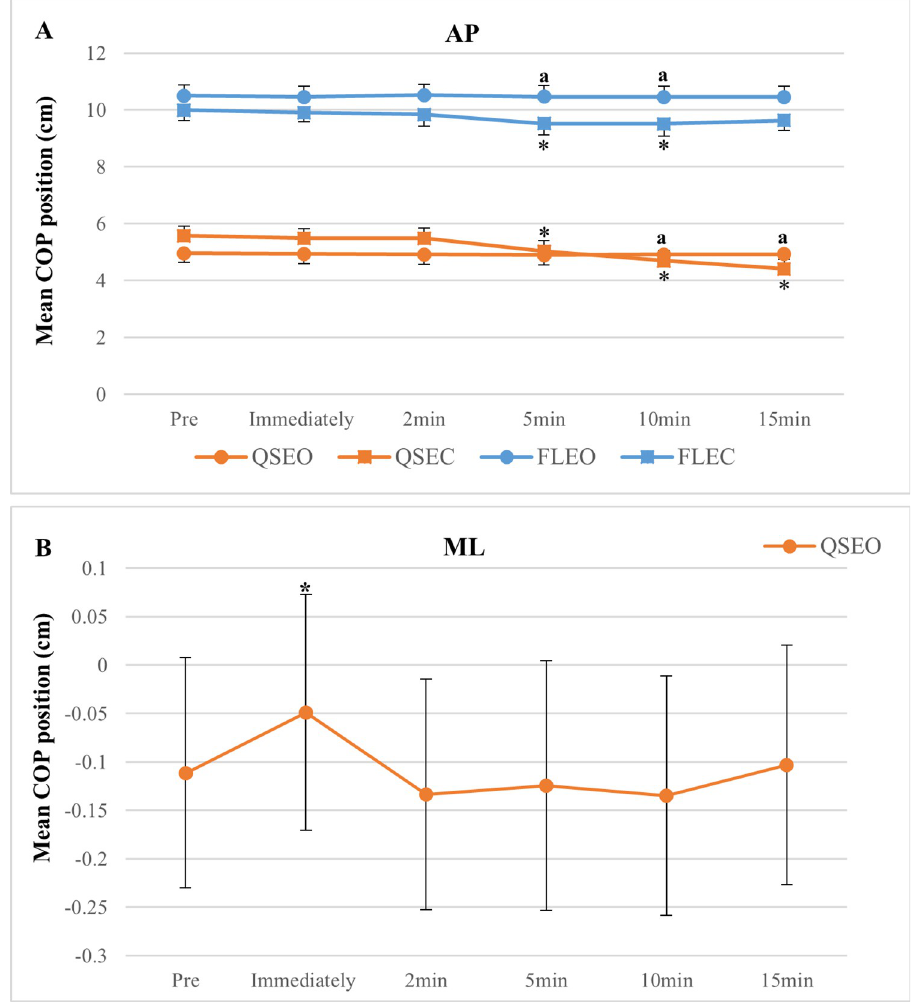
Fig 2. Mean anteroposterior (AP) and mediolateral (ML) COP position. Mean AP and ML COP positions shown before and immediately following exercise, and throughout the recovery period (2, 5, 10, and 15 min). Panel A shows the AP position during both quiet standing (QS) and standing forward leaning (FL) tasks with eyes open (EO) and closed (EC). B represents ML position during QS-EO. � = fatigue effects ( p � 0. 05, compared to pre-exercise value), and a = effects of fatigue X vision ( p � 0. 05, in comparing EO to